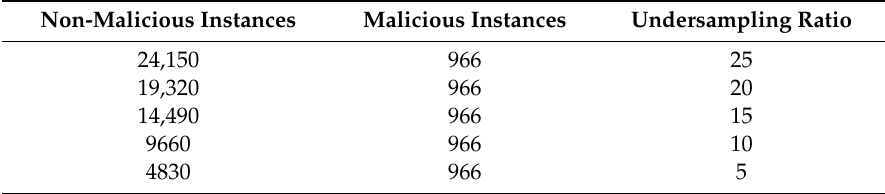
Table 4. Sampling ratio.